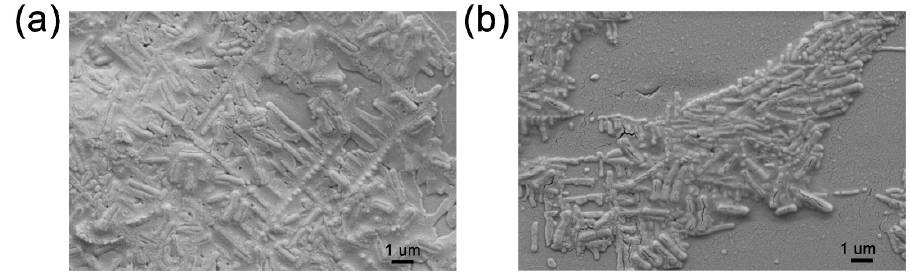
Figure 4. SEM images of ( a ) MIPs and ( b ) NIPs after the adsorption of L. monocytogenes (1.0 × 10 8 CFU mL − 1 ). CFU means the colony forming unit.